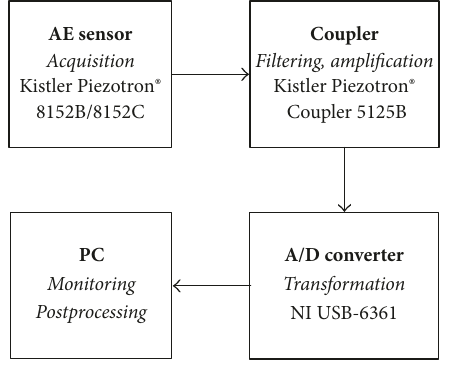
Figure 6: Acoustic emission (AE) evaluation